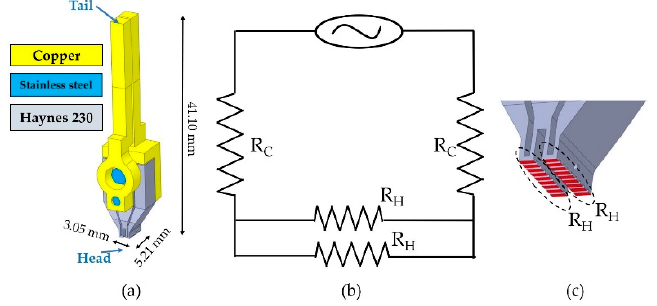
Figure 6. A parallel welding tip for ( a ) overview, ( b ) electric flow direction, and ( c ) enlarge head.